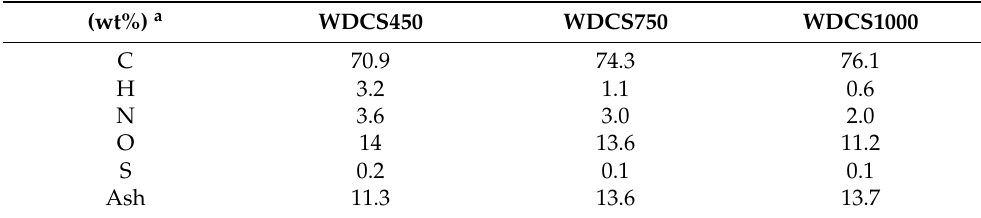
Table 3. Elemental analysis and ash content of the WDCSs obtained at different carbonization